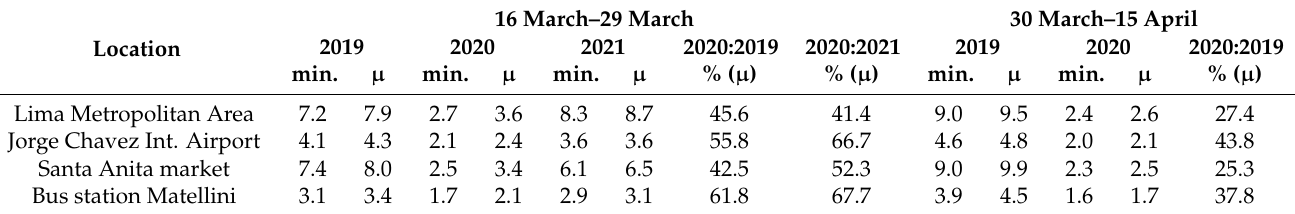
Figure 8. Nitrogen dioxide pollution difference between 2019 and 2020, from the range of 1 January to 4 July, when available, for the sensor locations indicated in Figure 6. Table 3. Numerical results of the NO 2 concentrations levels (in mol/m 2 ) for the locations of Lima Metropolitan Area, Jorge Chavez International Airport, Santa Anita market, and the bus station Matellini for the time ranges of (i) between 16 March and 29 March in 2019, 2020, and 2021 and (ii) between 30 March and 15 April in 2019 and 2020. The results are presented in terms of the minimum (min.) and the average ( µ ), both in the range of 10–5. We also show the ratio between the average values between 2020 versus 2019 and